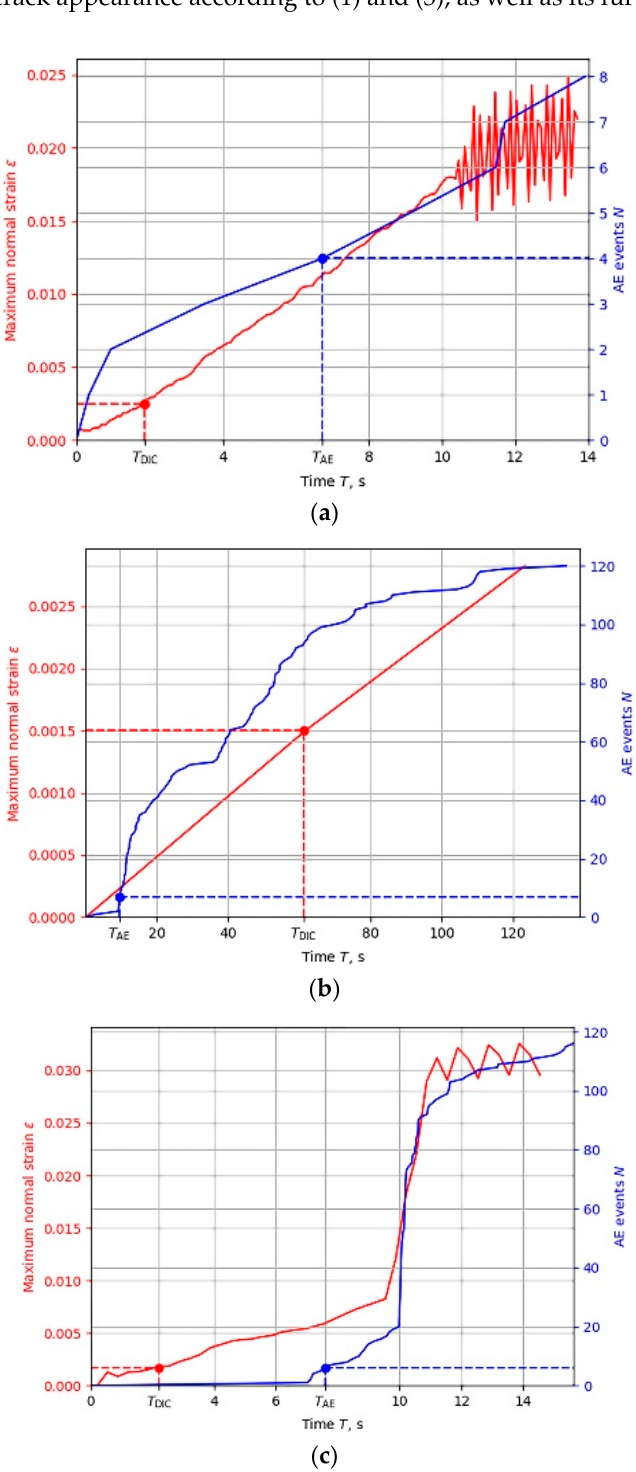
Figure 5. Temporal dependencies of AE (blue) and DIC (red) data in rail ( a ), wheelset ( b ), and traction clamp ( c )